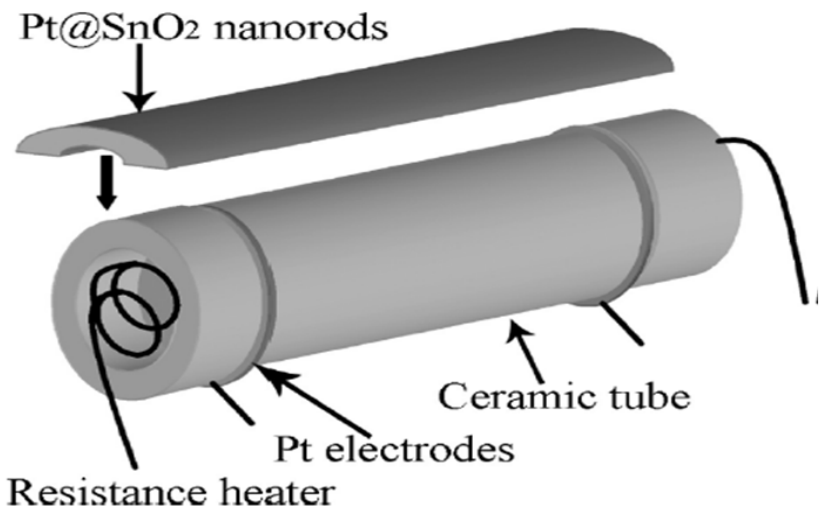
Figure 8. Schematic diagram showing Pt@SnO 2 nanorod-based gas sensor. (Reprinted with per- mission from [73]. Copyright 2010, American Chemical Society, Washington, DC, USA).